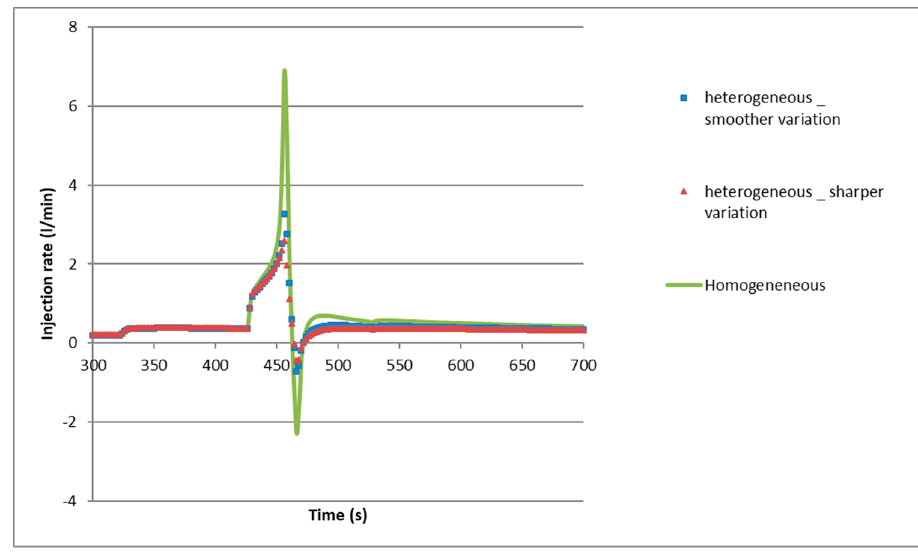
Figure 12. Comparison of injection rate between homogeneous and heterogeneous cases.